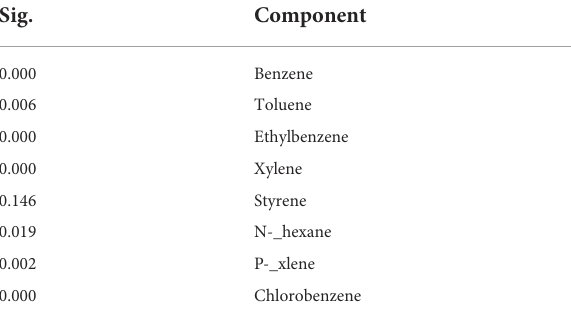
TABLE 8 The results of the T -test between two sampling areas (pit and refinery areas).